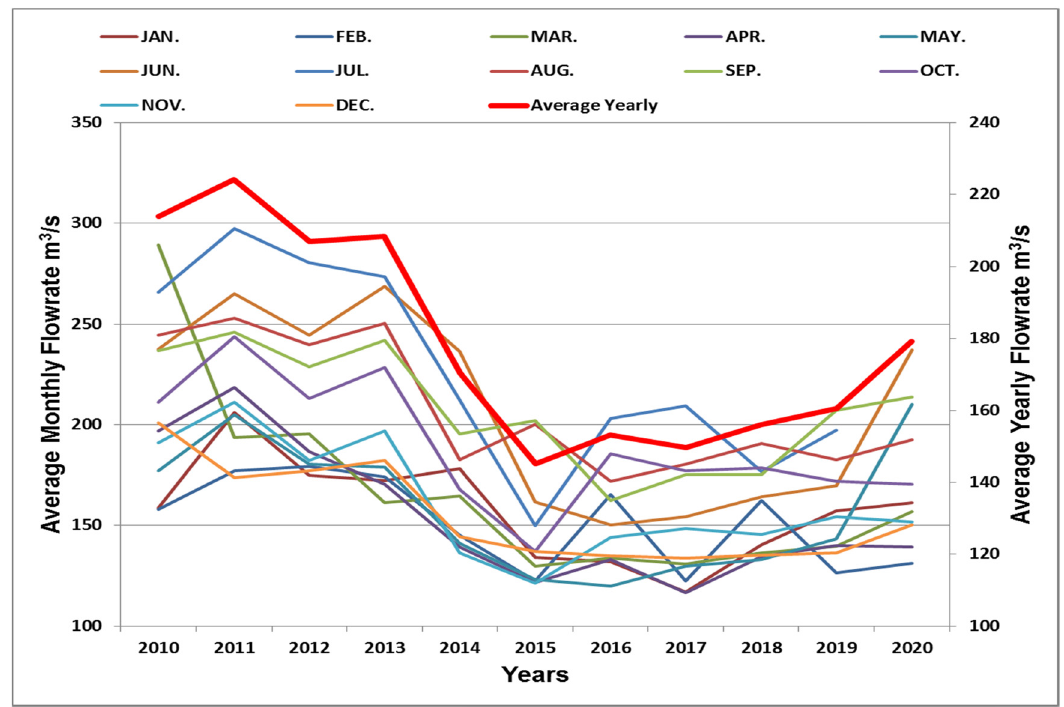
Figure 3: Average fl owrate of the Al - Kufa river recorded at 44 stations between 2010 and